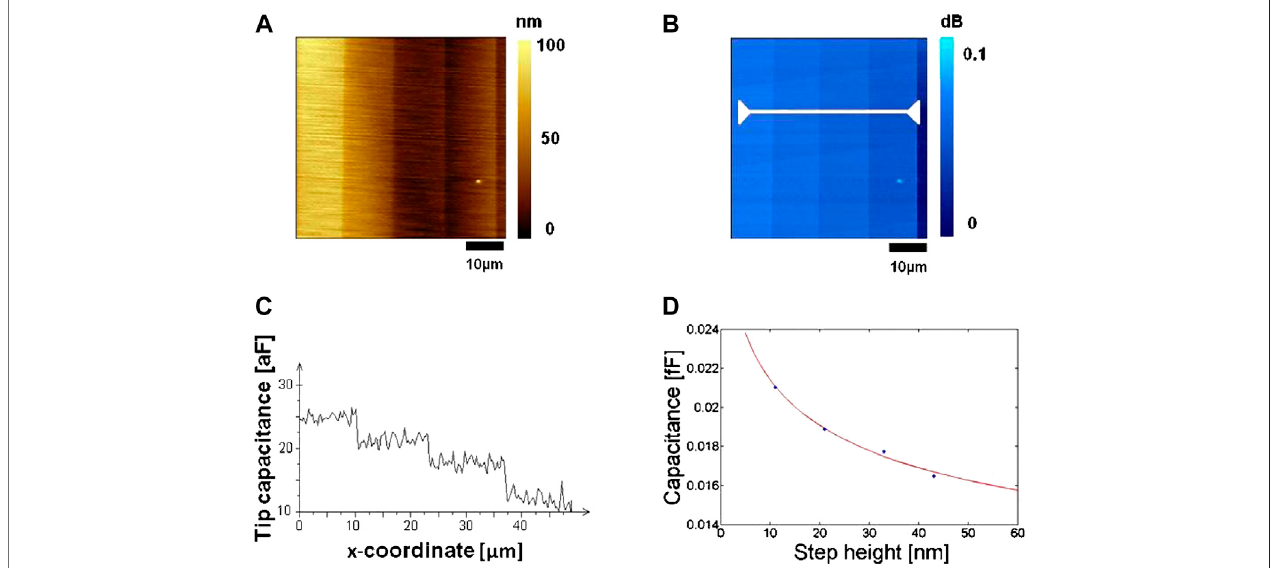
FIGURE 9 | AFM-tip/sample capacitance and effective tip radius. [70] (A) Topographical image of the bare 10 nm stepped dielectric staircase structure. (B) Corresponding PNA amplitude image with the different steps resolved (0 dB corresponds to the bare silicon surface, as seen at the far-right edge of the image). (C) The PNA amplitudes were converted to capacitances and plotted concerning the x-coordinate of the white line in (B) . (D) For each dielectric step, the capacitance was determined using an area analysis and subsequent averaging of the PNA amplitude [70]. Reproduced with permission from Rev. Sci. Instrum. 81, 11 (2010). Copyright 2010 American Institute of Physics.